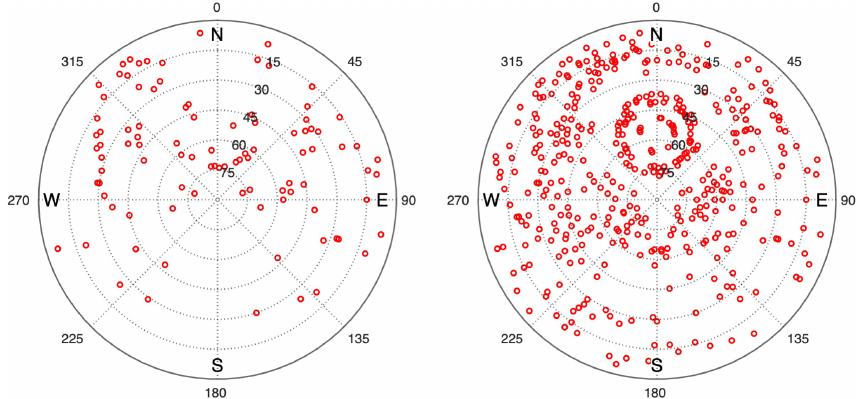
Figure 7. The directions of the VLBI observations for the time period from 06:00 to 12:00UT (a) and from 00:00 to 24:00UT (b) , both on 12 May 2014.